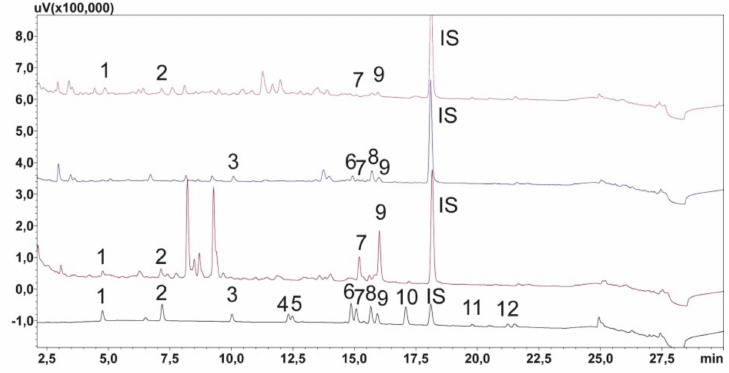
Chromatogram of saliva extracts of patients treated with studied